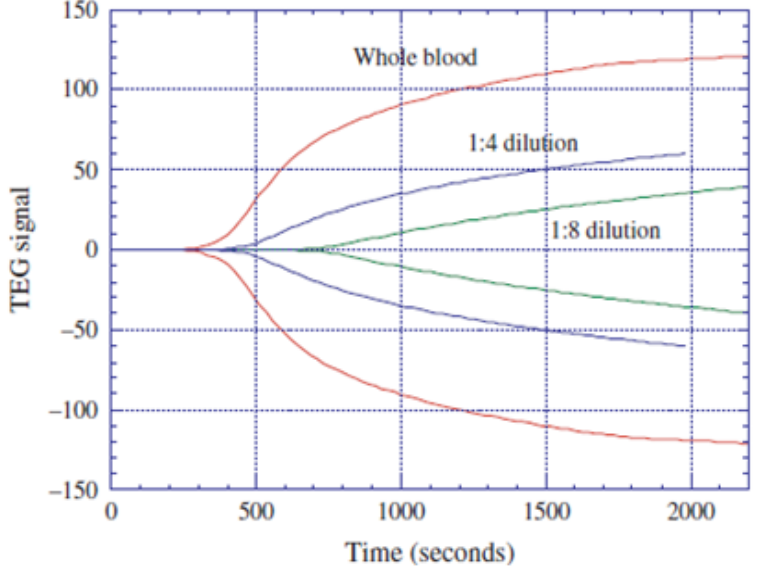
Figure 32. TEG-like profiles of blood samples obtained with an magnetoelastic sensing system. Reprinted with permission from [30].